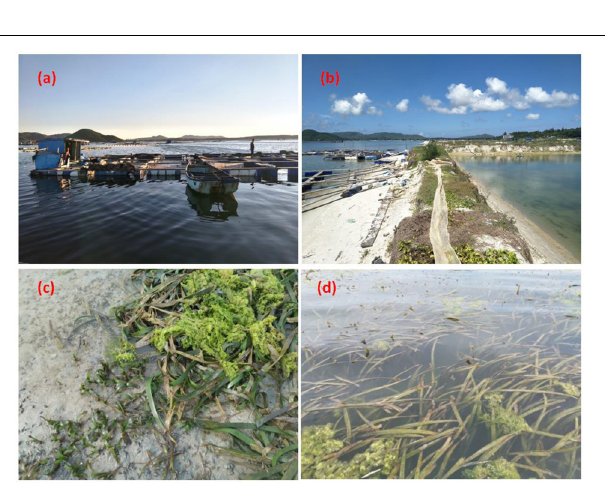
FIGURE 7 | The threats including fish caging (a) , shrimp pond culture (b) , and macroalgae bloom (c,d) in seagrass beds in Li’an gang, Hainan